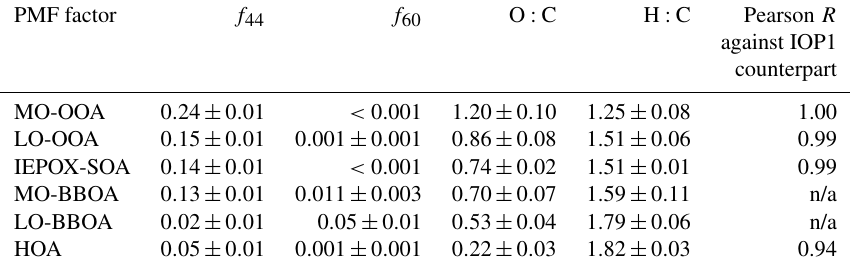
Table 1. Characteristics of the PMF factor profiles. Listed are f 44 and f 60 , corresponding to the organic signal fraction at m/z 44 and 60, respectively, as well as the oxygen-to-carbon (O : C) and hydrogen-to-carbon (H : C) ratios. Values and uncertainties were calculated by running the PMF analysis in “bootstrap mode” (Ulbrich et al., 2009). The Pearson R correlations between the factor profiles of IOP2 and their counterparts in IOP1 are also listed (i.e., dry season compared to wet season). “n/a” means “not applicable”. Elemental ratios were calibrated by the “improved-ambient” method, which has an estimated uncertainty of 12% for O : C and 4% for H : C (Canagaratna et al., 2015). PMF factor f 44 f 60 O : C H : C Pearson R against IOP1 counterpart MO-OOA 0 . 24 ± 0 . 01 < 0 . 001 1 . 20 ± 0 . 10 1 . 25 ± 0 . 08 1.00 LO-OOA 0 . 15 ± 0 . 01 0 . 001 ± 0 .